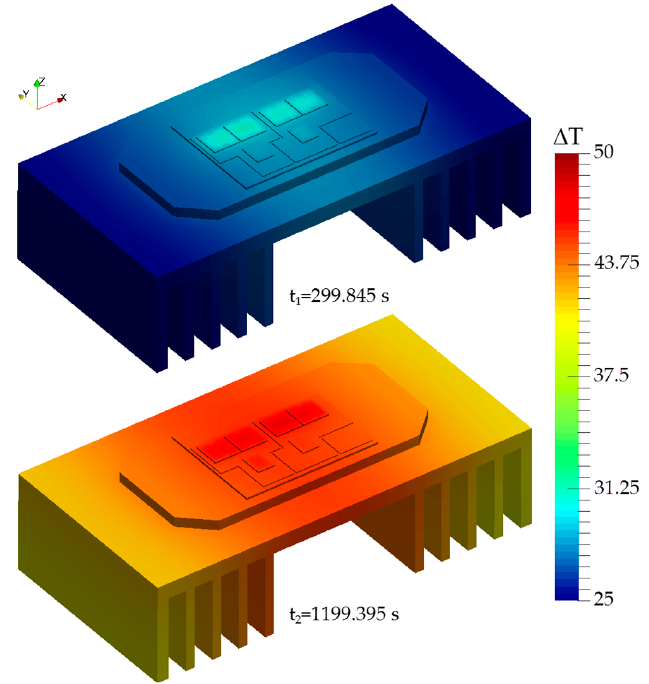
Figure 7. Two temperature maps at the time instants t 1 = 299.845 s and t 2 = 1199.395 s of the module under test equipped with a 2.5 K/W heatsink.